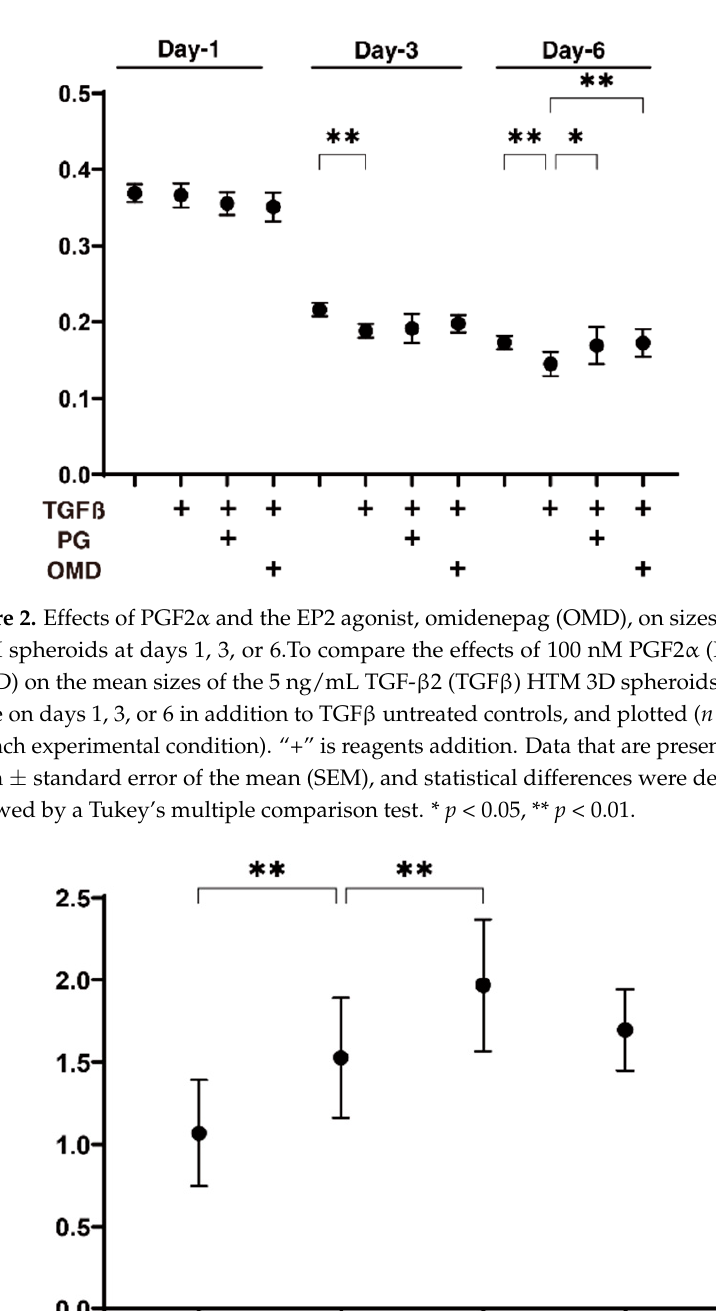
Figure 2. Effects of PGF2 α and the EP2 agonist, omidenepag (OMD), on sizes of TGF β 2-treated 3D